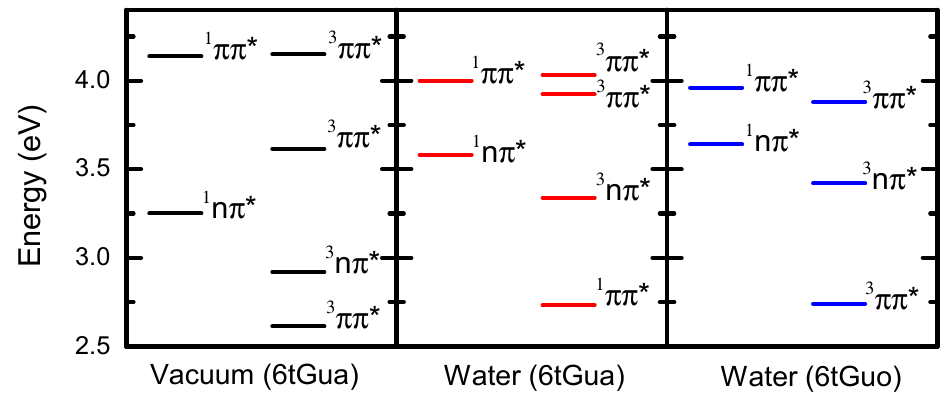
Figure 4. Vertical excitation energies for 6tGua in vacuum and in water environments, and for 6tGuo in water, calculated at the TD-PBE0/IEFPCM/6-311++G(d,p) level of theory. 6tGuo values were reported previously [26].